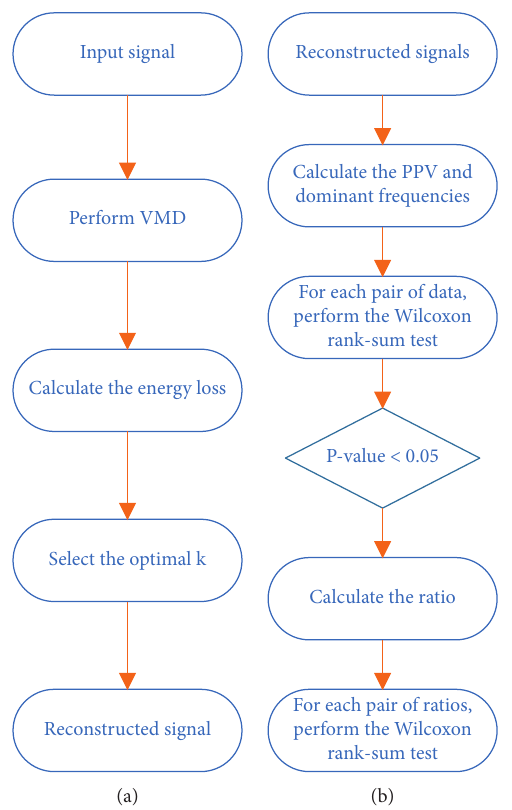
Figure 2: Analysis flowcharts: (a) reconstructed signal generation; (b) hollow effect evaluation.